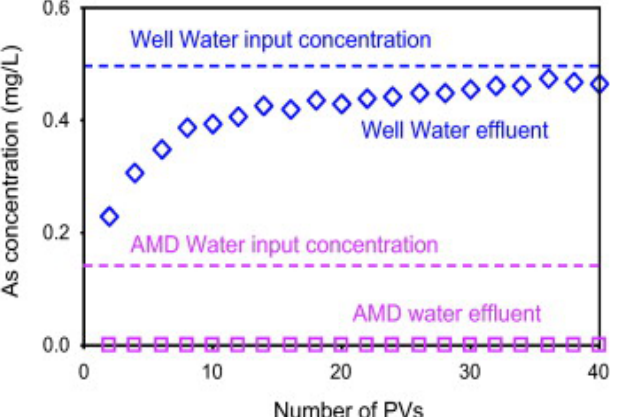
Figure 9. As concentrations from a column test effluent for the acid mine drainage (AMD) wastewater and groundwater (after [68]).